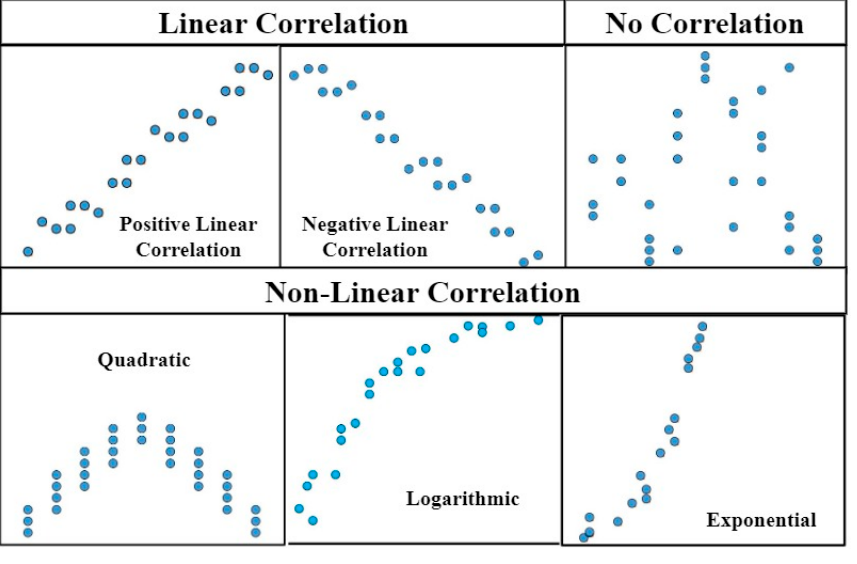
Figure 1. Scatterplot patterns [31].